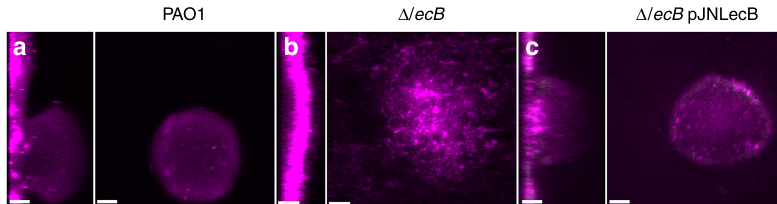
Fig. 5 LecB mutants display a defect on mature aggregate formation under fl ow conditions. a PAO1 4-day-old bio fi lm displays a complex mature structure in NB media while b Δ lecB 4-day-old bio fi lm do not fully develop into mature structures. c Complemented strain Δ lecB pJNLecB 0.05% arabinose 4-day-old bio fi lm develop structures that are very similar to PAO1. Bio fi lms are stained for biomass with Syto 62 at 2.5 µ M. Scale bars = 25 µ